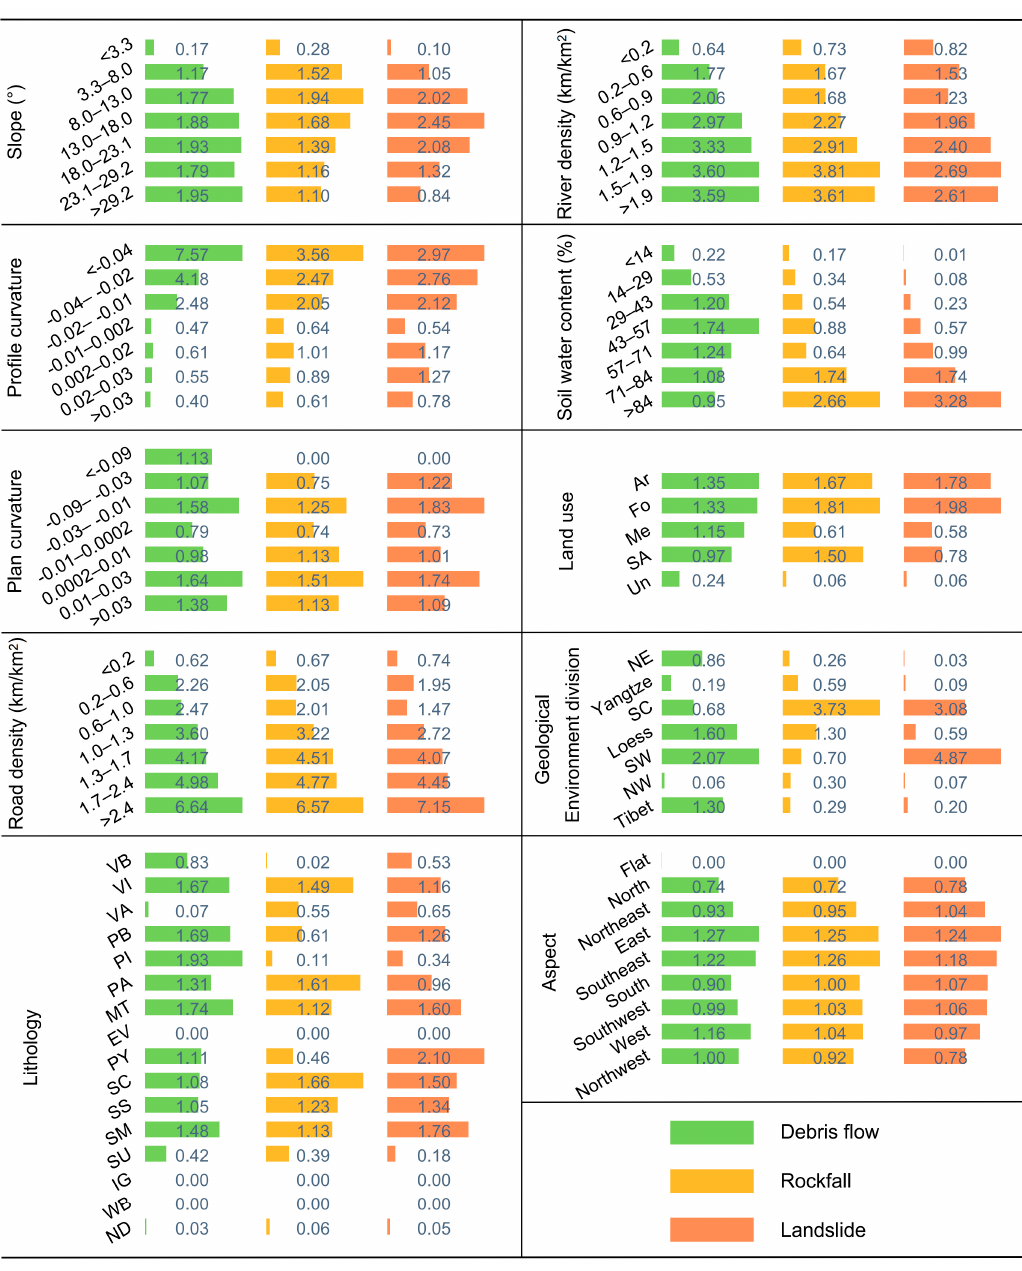
Figure 5. Correlations between three types of mass movements and influencing factors.